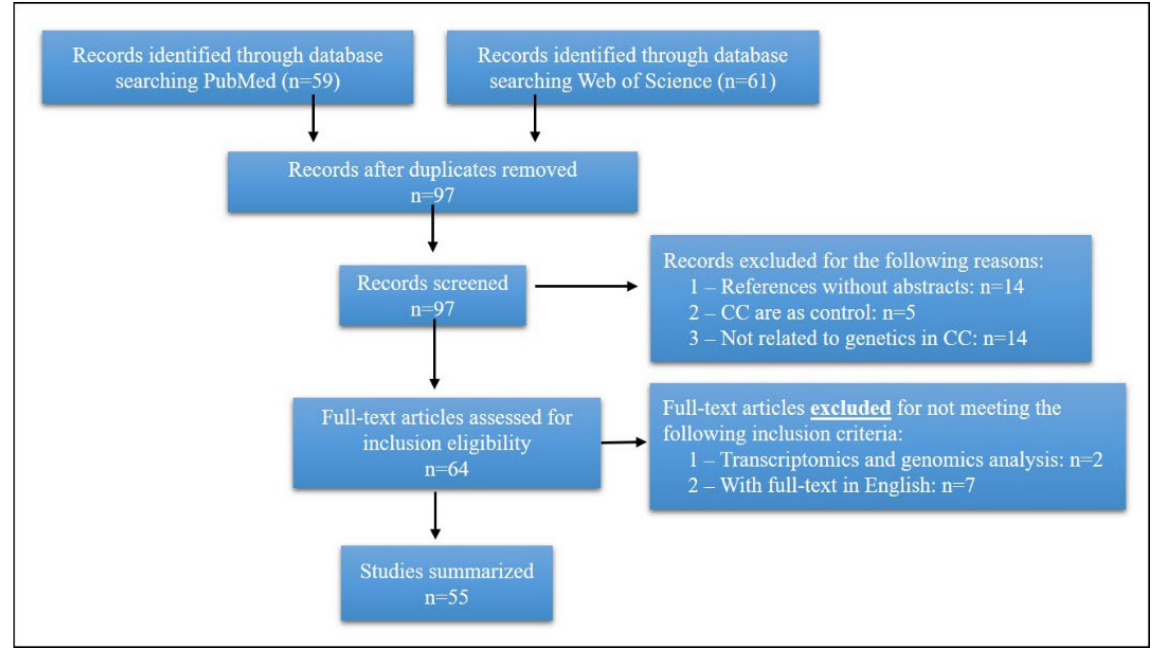
Figure 1. Flow-chart showing the search strategy and inclusion/exclusion criteria used in the review.